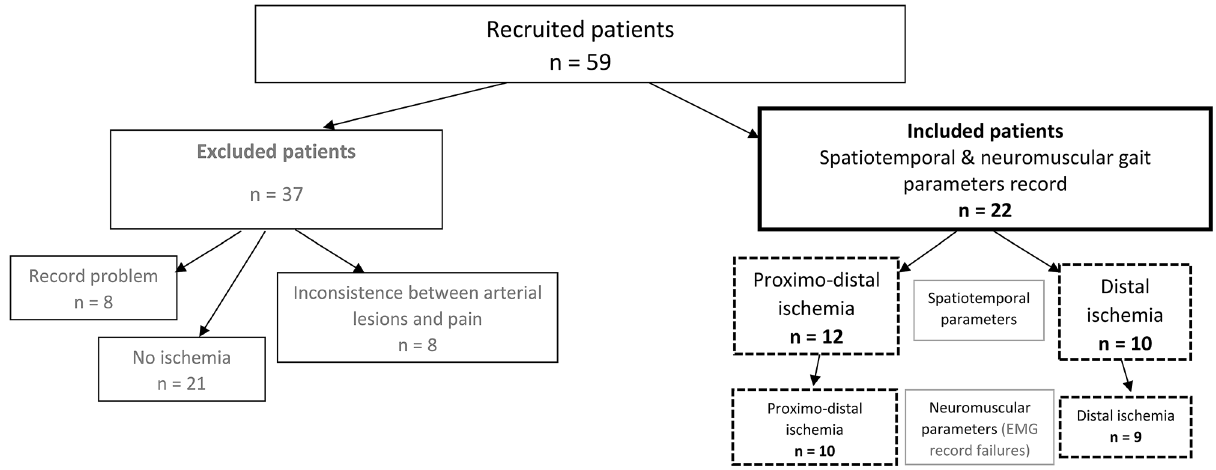
Figure 1. Flowchart of the population